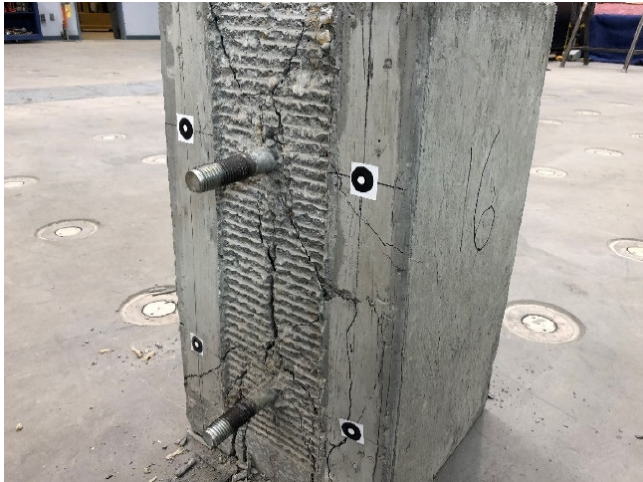
Figure 8. Compression-Shear Specimen after Loading to Failure.